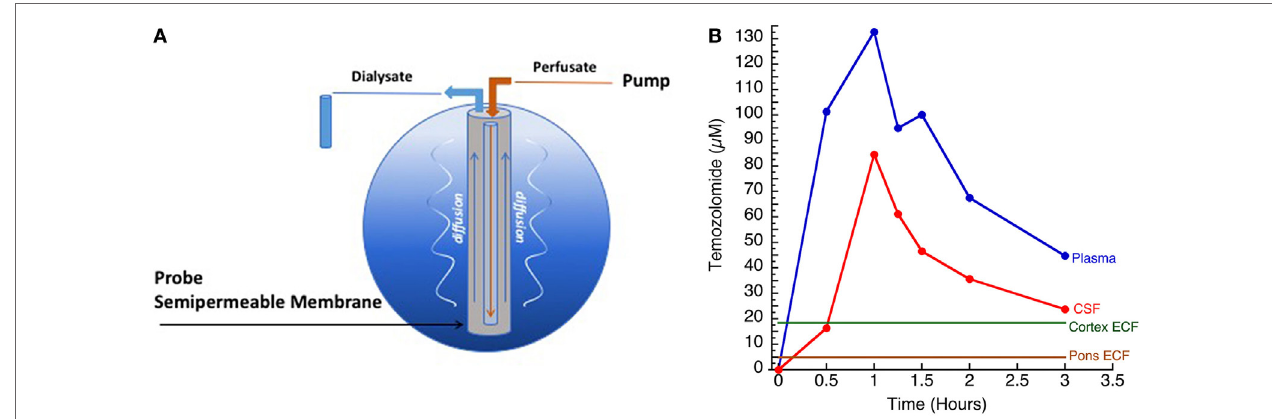
FiGURe 2 | (a) Illustration of microdialysis setup. Drug of interest (TMZ) was administered systemically. (B) Concentration versus time curves of temozolomide measured in plasma, cerebrospinal fluid (CSF), cortex ECF, and pontine ECF ( courtesy of Cindy McCully